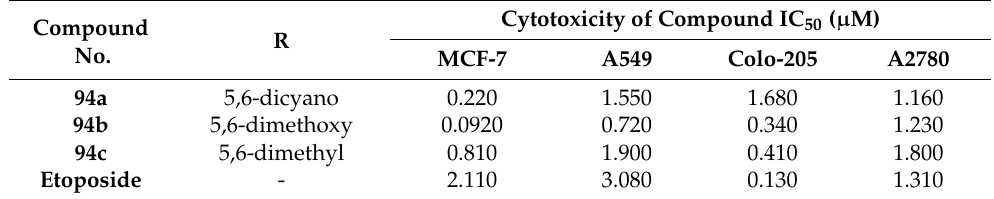
Figure 91. Structure of benzimidazole- β -Carboline derivatives ( 94 ). Table 80. In vitro cytotoxic activities of benzimidazole- β -Carboline hybrid compounds 94 ( a – c ).